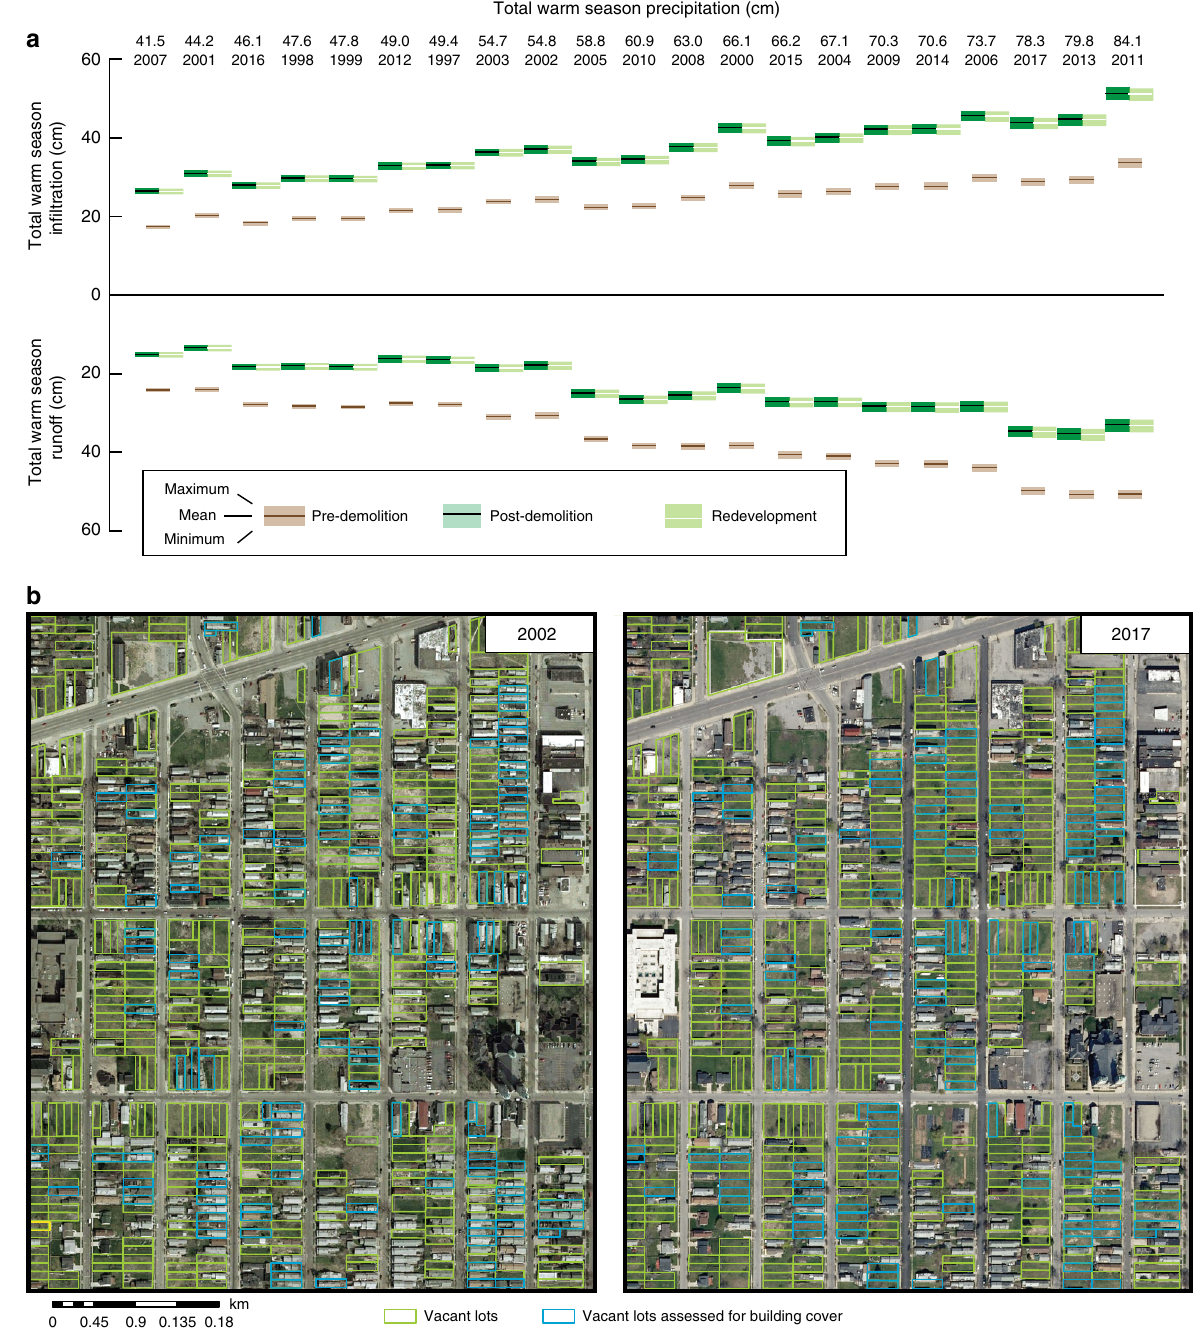
Fig. 4 Interactions between pervious area and precipitation partitioning between in fi ltration and runoff for 2482 lots. Values are presented as a cumulative depths (normalized by parcel area) for three end-member states (pre-demolition, post-demolition, redeveloped) that have b introduced a patchwork landscape of green space across the city. Ranges show minimum and maximum values obtained by resampling in fi ltration observations 1000